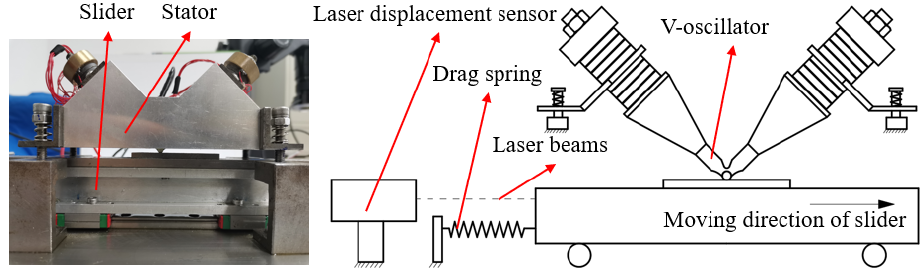
Figure 12. Illustration of a homemade ultrasonic motor and the testing sketch for friction-driving performances.